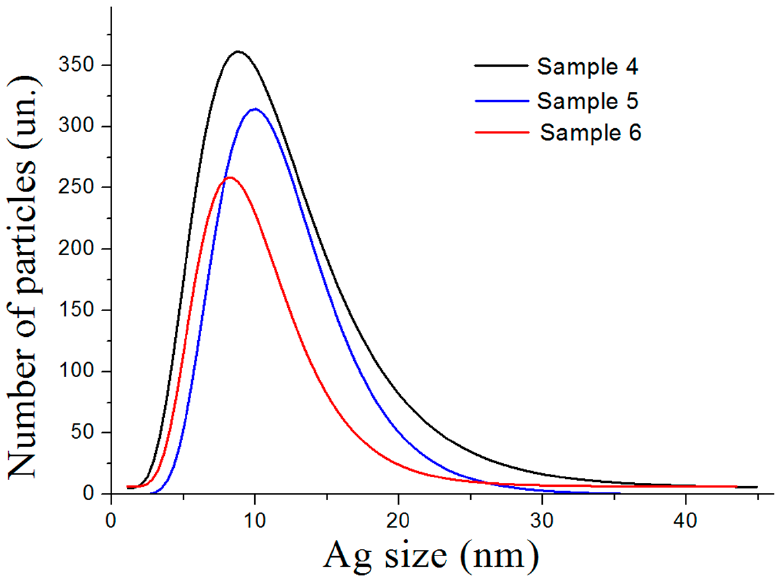
Figure 12. Size distribution of Ag nanoparticles resulted from the thermal treatment of nanostructures at 500 °C.